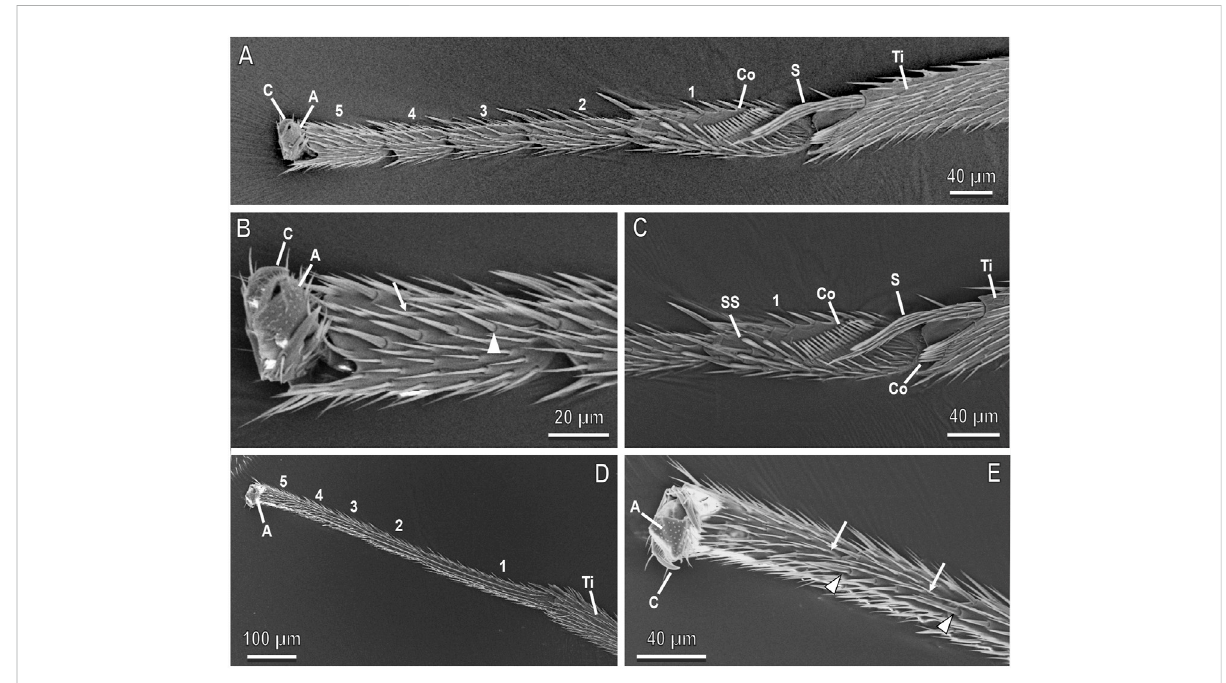
FIGURE 3 Tarsiofthefemaleof A.bifasciatus incryo-SEM.Forelegs (A – C) andhindlegs (D , E) showingthe fi vetarsomeres(1 – 5),thepretarsalclaws(C)and arolium (A), the tibia (Ti) with the tibial spur (S), the cleaning structures with the comb (Co) and the spatulate setae (SS). Note the setae (arrowheads) and microtrichia (arrows) along the inner side of the